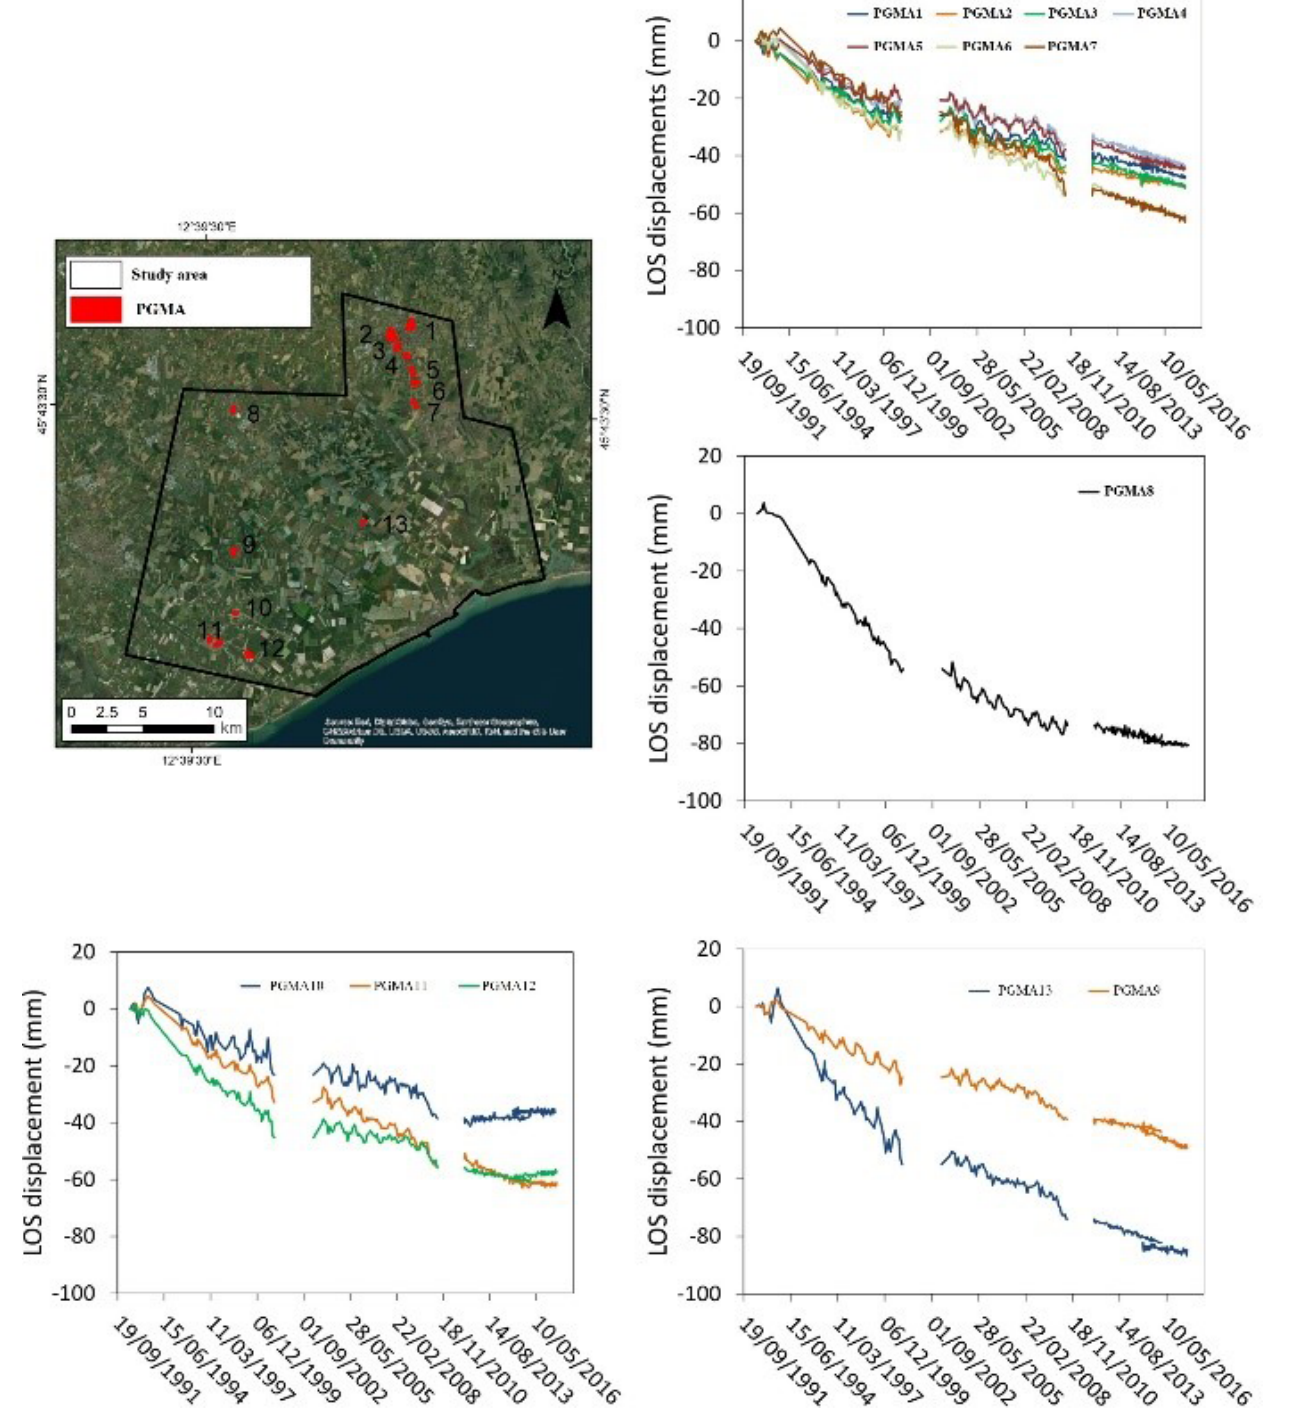
Figure 6. Persistent GMA detected using ERS-1/2, ENVISAT, Cosmo-SkyMED (CSK) and Sentinel-1 data in the period from 1992–2017. The LOS displacement time for each persistent GMA are also